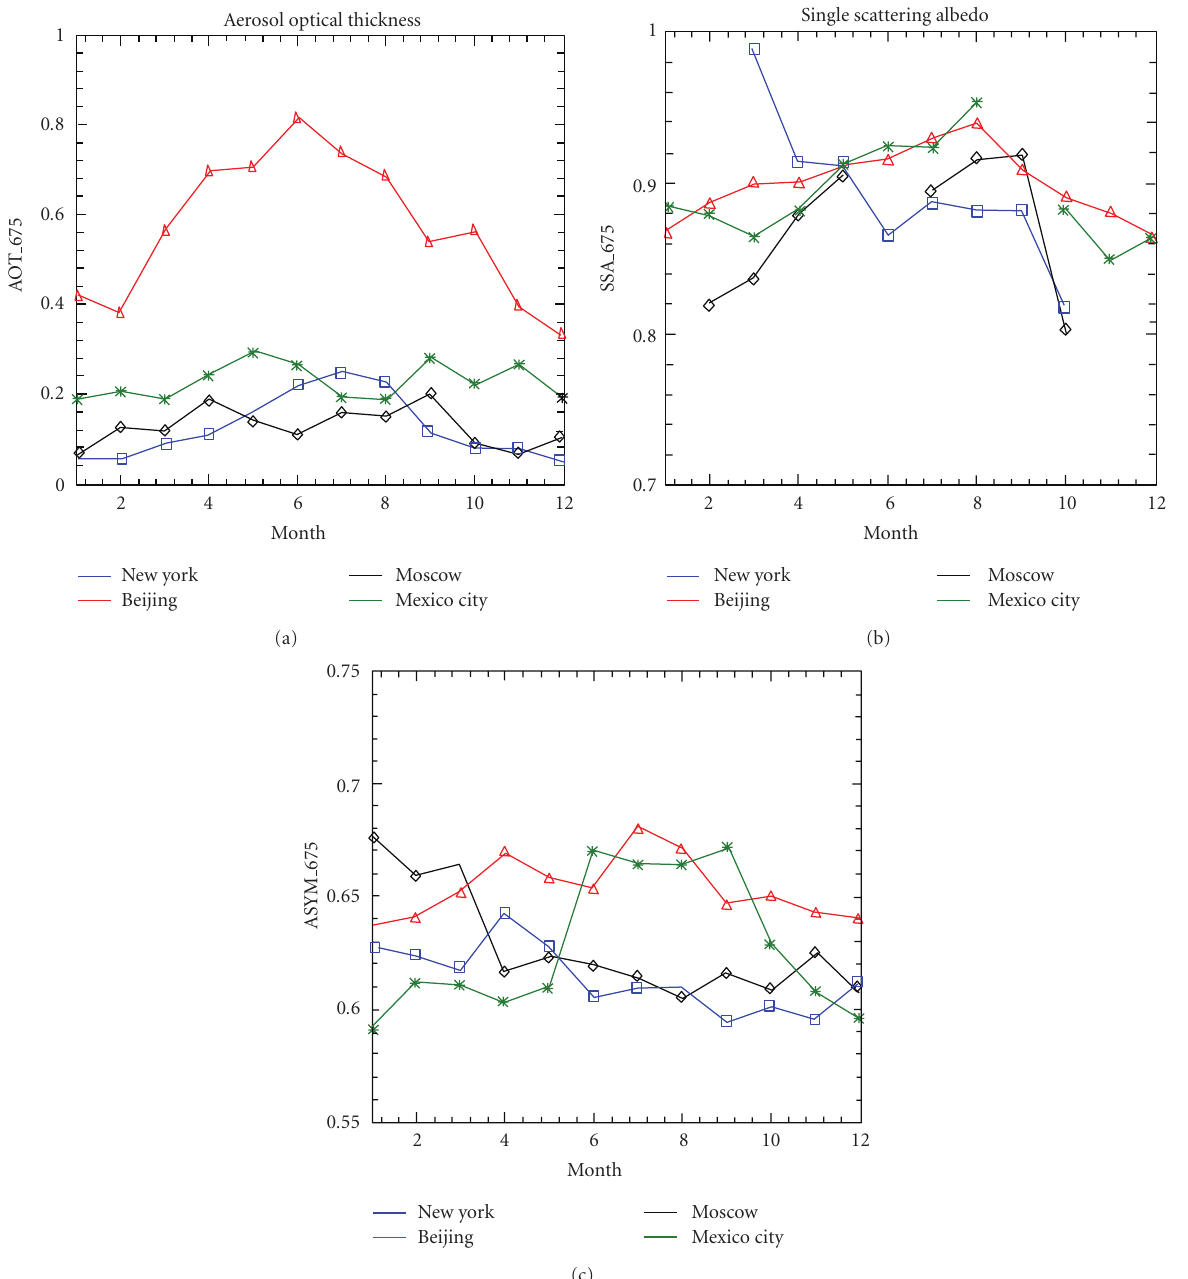
Figure 4: Monthly observations for (a) aerosol optical thickness, (b) single scattering albedo, and (c) the asymmetry factor from NASA AERONET sites for four cities (Beijing, New York City, Mexico City, and Moscow). Data are sampled from multiyear averages.